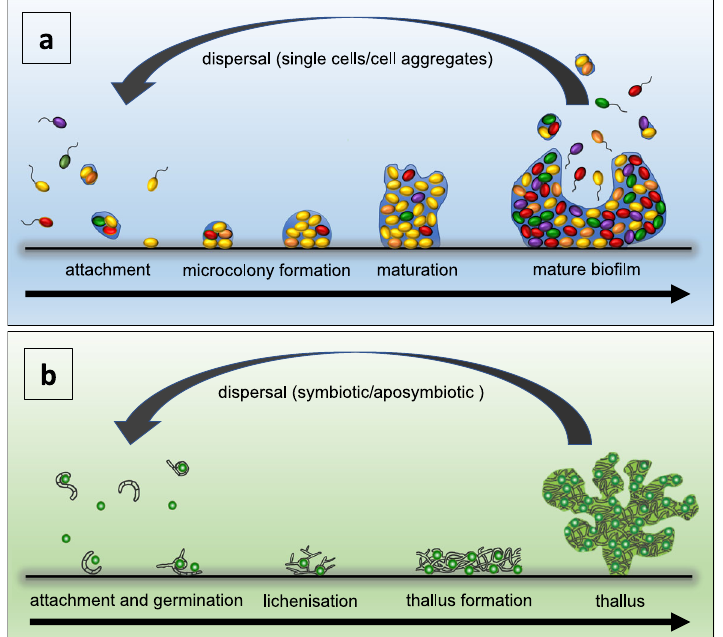
Fig. 1 The life cycle of bio fi lms (panel a), and key stages involved in the vegetative reproduction of lichens (panel b). Panel a depicts the main stages of bio fi lm development, i.e., the attachment of cells/cell aggregates to a substratum, formation of microcolonies and their maturation, followed by dispersal of single motile cells and cell aggregates from bio fi lms. Panel b shows key stages involved in the vegetative reproduction of lichens, including the attachment and growth of symbiotic aggregates (consisting of fungal and algal cells) that are detached from the main lichen thallus, or via aposymbiotic dispersal and germination of fungi followed by re-engagement of algal partners and lichenisation 94